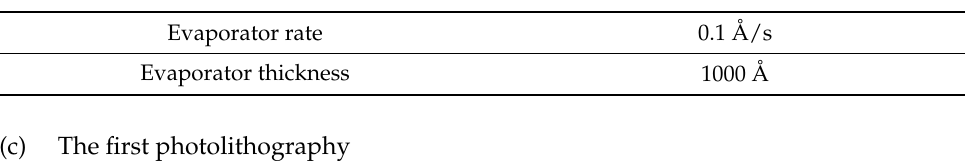
Figure 7. Process chart of flexible six-in-one microsensor. Table 1. The process parameters of